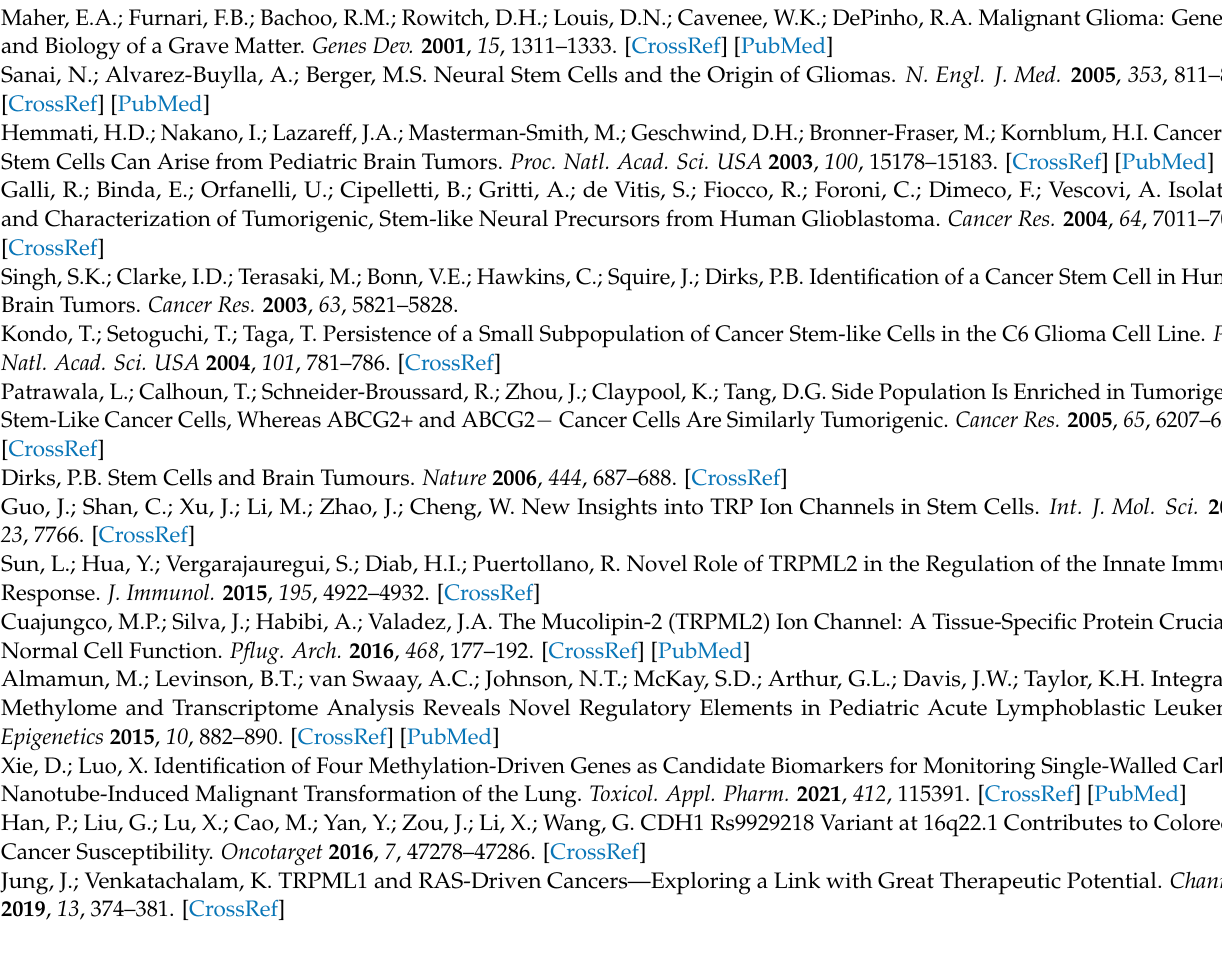
Table S2: Kaplan–Meier p -values; Table S3: Drug Transporters expression in pCMV-TRPML2 GSC#1 and siTRPML2 GSC#83 lines; Table S4: Kaplan-Meier p